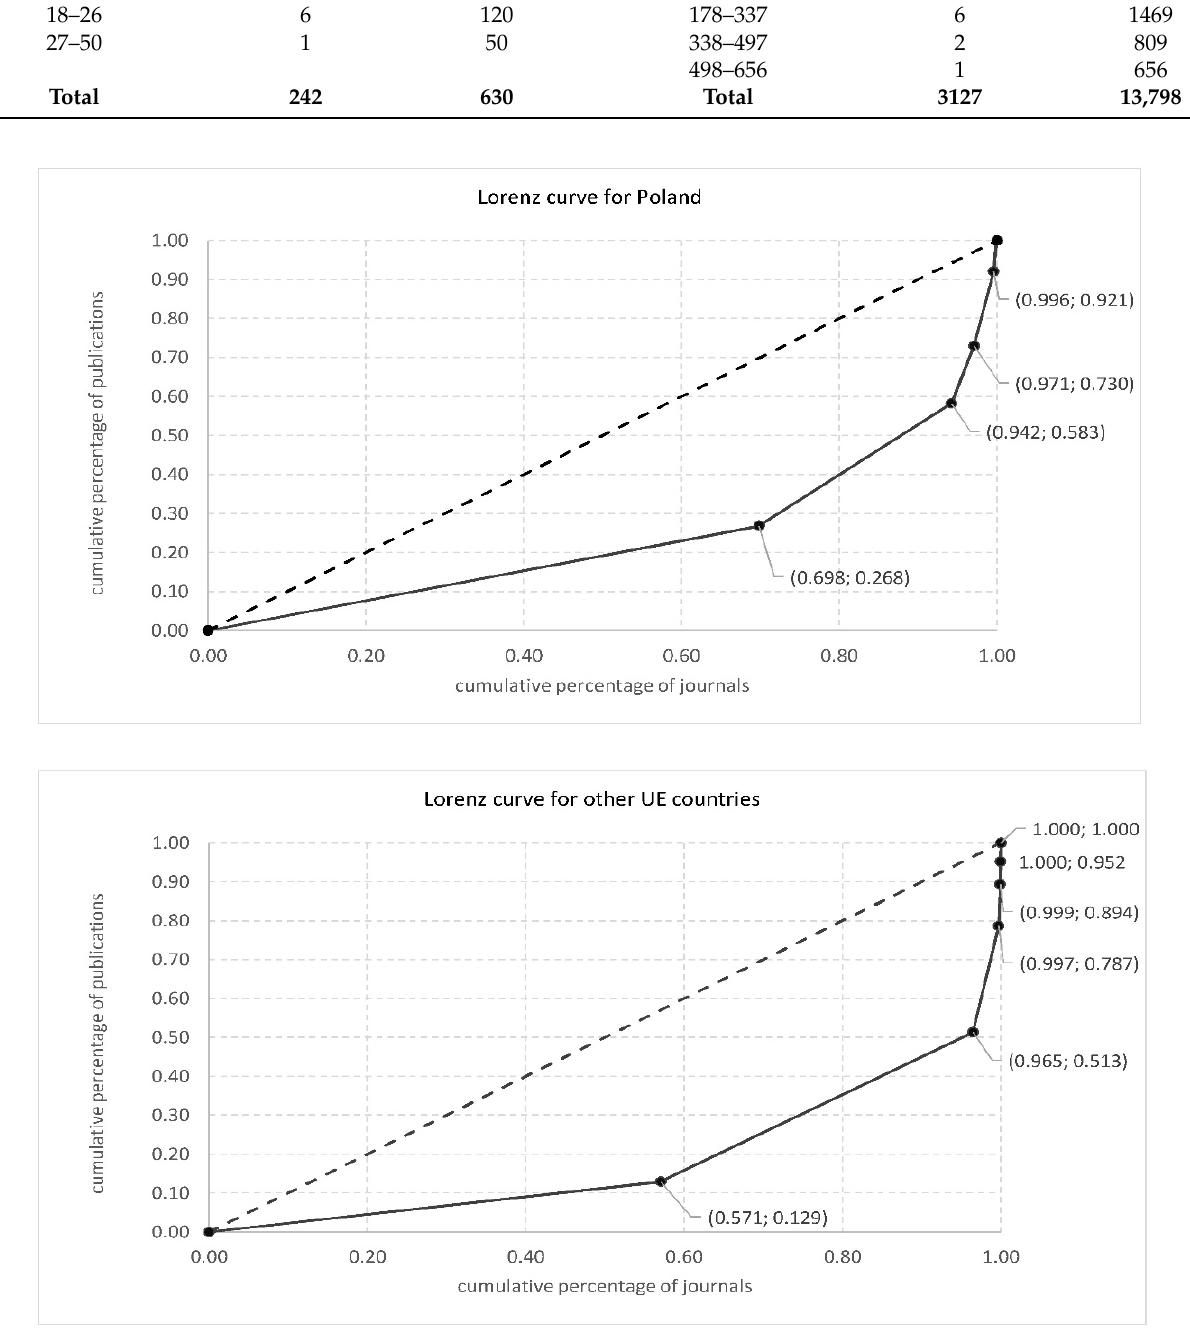
Figure 1. Lorenz curves—the illustration of the concentration degree of RE publications (Scopus, 2005–2021).